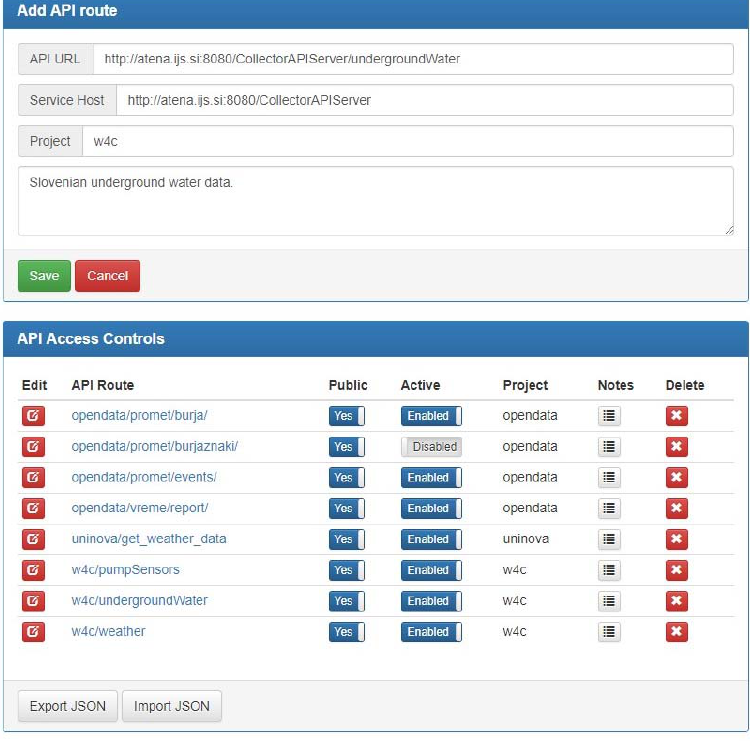
Figure 3. API Management tool web interface—API